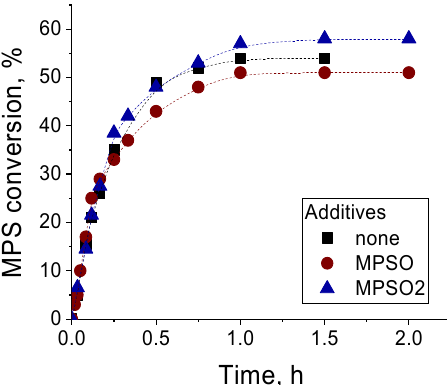
Figure 14. Effect of reaction products on MPS oxidation with H 2 O 2 over Zr-MMM-E (sample D) . Reaction conditions: MPS 0.1 mmol, catalyst 5 mg (0.0013 mmol Zr), H 2 O 2 (30% aq.) 0.1 mmol, CH 3 CN 1 mL, 60 °C. Additives: 0.02 mmol of MPSO or MPSO 2 (added in the beginning of the reaction).